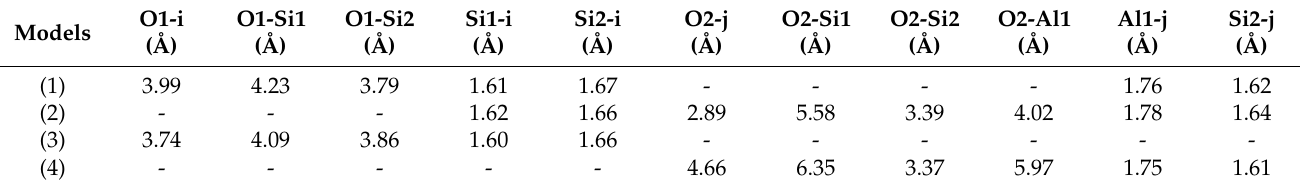
Table 2. The distances between the oxygen from water, Si, Al, and oxo-bridging in the reactants (A), as shown in Figures 3–6.